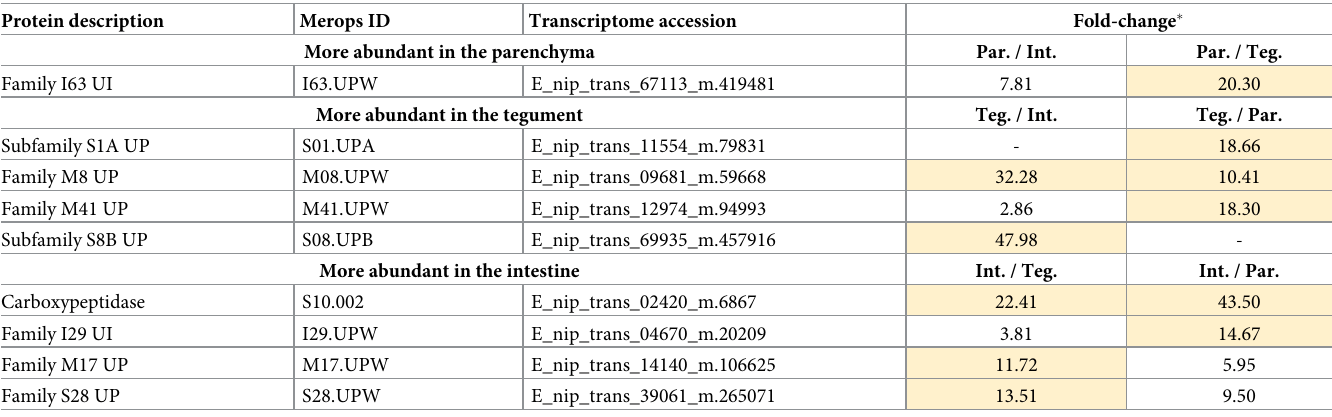
Table 2. List of the most abundant peptidases and